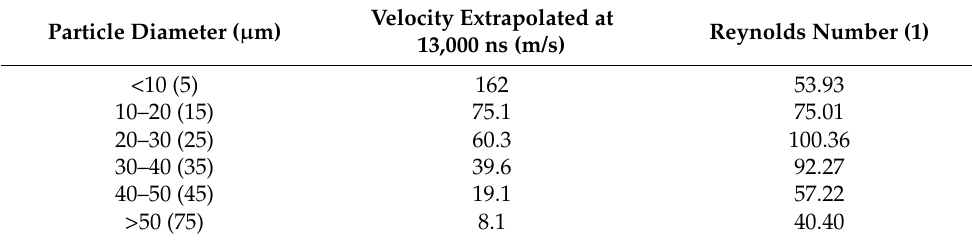
Table 1. Longitudinal velocity (Reynold number) of particles extrapolated at 13,000